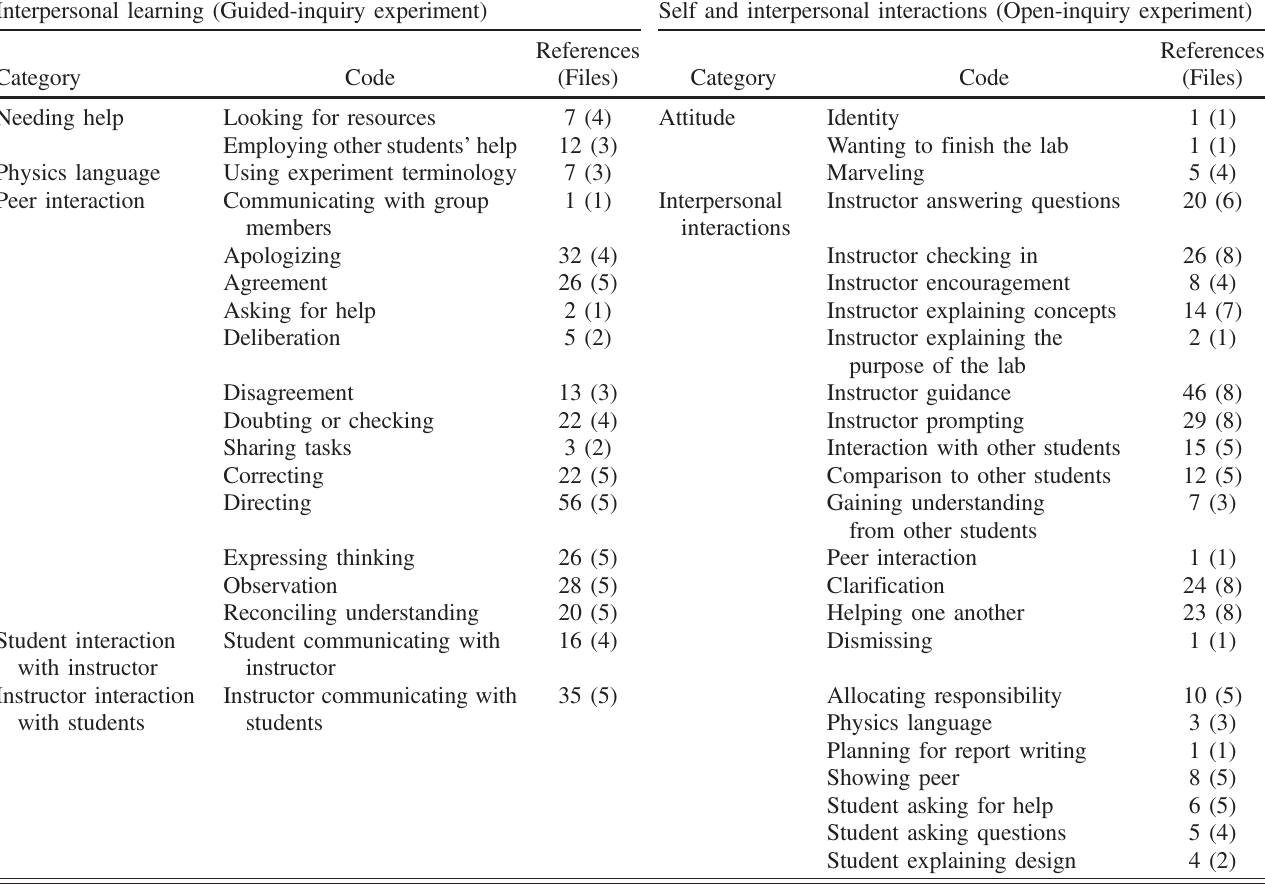
TABLE VII. Open codes that are unique in the interpersonal learning theme in the guided-inquiry data set in comparison to the self and interpersonal interactions theme in the open-inquiry data set. The numbers shown in the table are how many times each code is referenced in the corresponding experiment and how many files each code is referenced (shown in parentheses). Note that there are a total of 5 guided-inquiry files and 8 open-inquiry